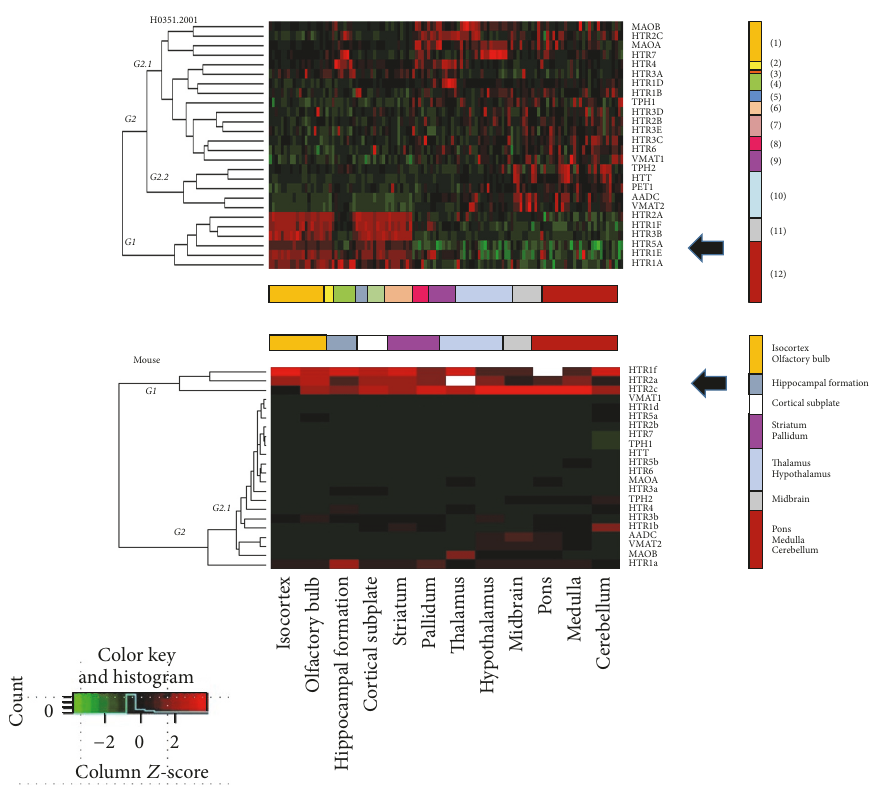
Figure 5: Heatmaps of gene expression of serotonin system in donor H0351,2001 (microarray) and mouse (hybridisation in situ). On the left, dendrogram with organization in two main groups (G1 and G2). The second group has two branches or trees. Below each heatmap a color representation of brain structures. Group 1 is related to height expression in structures at cerebral cortex in general (white black) in both species. The column on the right for donor has the convention of colors: (1) Frontal Lobe; (2) Insula; (3) Limbic Lobe; (4) Hippocampal Formation; (5) Occipital Lobe; (6) Parietal Lobe; (7) Temporal Lobe; (8) Amygdala; (9) Basal Ganglia; (10) Diencephalon; (11) Mesencephalon; (12) Hindbrain. Convention in mouse expression was made similar to